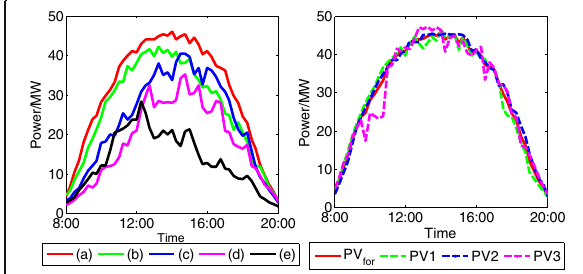
Fig. 7 Typical scenarios and the output curves of representative scenario in winter